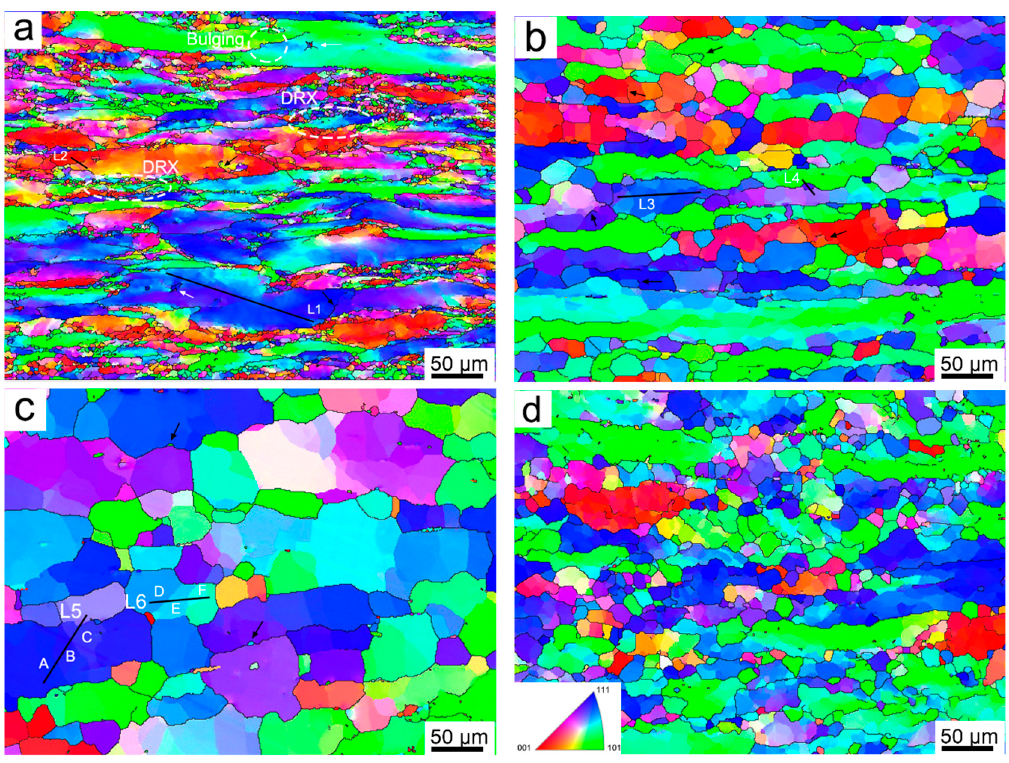
Figure 6. Inverse pole figure (IPF)-coloring orientation map for the 0Cr18AlSi steel tested under di ff erent deformation conditions: ( a ) 1.7 × 10 − 4 s − 1 and 873 K; ( b ) 1.7 × 10 − 4 s − 1 and 1023 K; ( c ) 1.7 × 10 − 4 s − 1 and 1123 K; ( d ) 1.7 × 10 − 2 s − 1 and 1123 K.